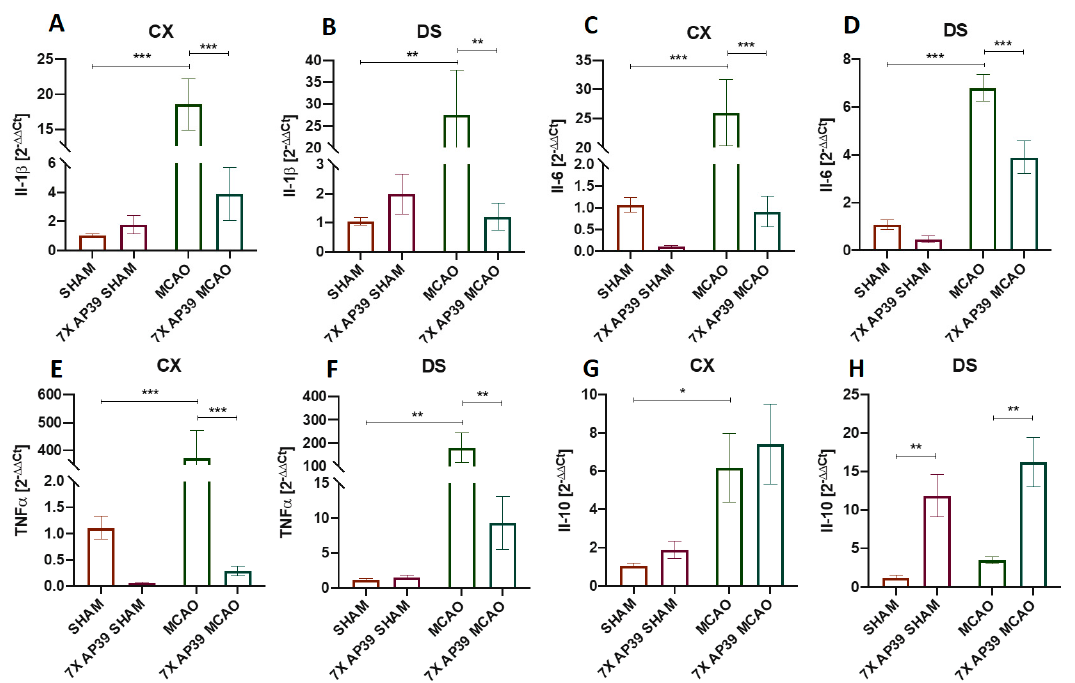
Figure 3. The effect of MCAO and AP39 on the mRNA expression level of the proinflammatory and anti-inflammatory cytokines in the frontal cortex (CX) and in the dorsal striatum (DS). ( A , B ) Relative Il-1ß mRNA levels in the CX and DS, respectively. ( C , D ) Relative Il-6 mRNA levels in the CX and DS, respectively. ( E , F ) Relative TNF- α mRNA levels in the CX and DS, respectively. ( G , H ) Relative Il-10 mRNA levels in the CX and DS, respectively. n = 8, one-way ANOVA, followed by Sidak’s correction for post hoc comparisons; * p < 0.05, ** p < 0.01 and *** p < 0.001 vs. MCAO or SHAM. Data are presented as the mean ±